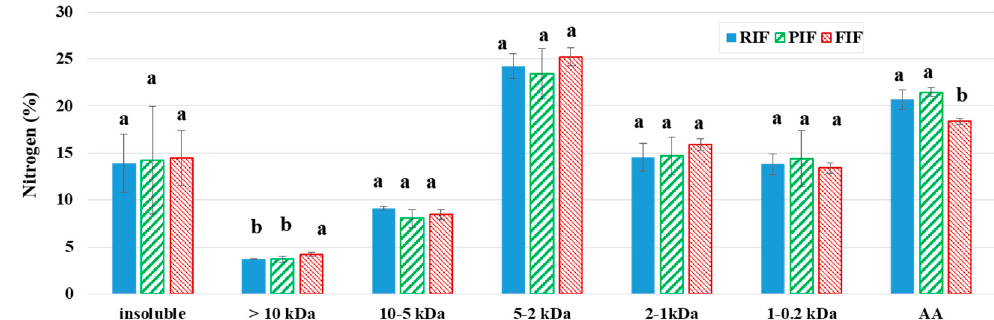
Figure 3. Nitrogen molecular size distribution (%) of RIF (reference IF), PIF (pea IF), and FIF (faba bean IF) determined at the end of in vitro dynamic digestion (in intestinal compartment and intestinal emptied fraction mixed). Data are means ± SD ( n = 3). Values with a different superscript letter are significantly different ( p < 0.05).